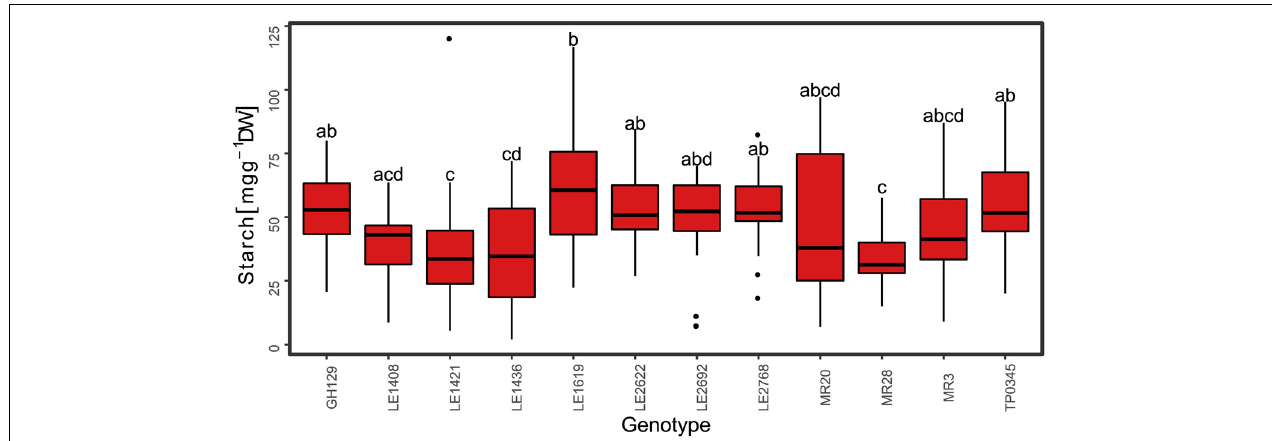
FIGURE 5 | Starch content in mg g − 1 DW for the red clover genotypes of the training set harvested at the end of the day (ED; n = 226). Medians with no letter in common are significantly different (Kruskal-Wallis, α = 5%).